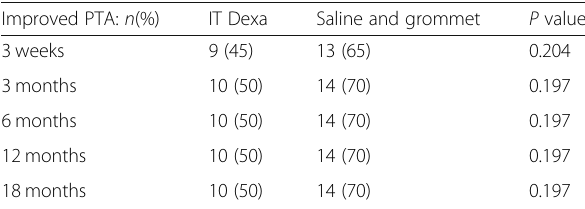
Table 8 Comparison of the 2 disease duration groups in the total sample regarding improvement in PTA by chi-square test